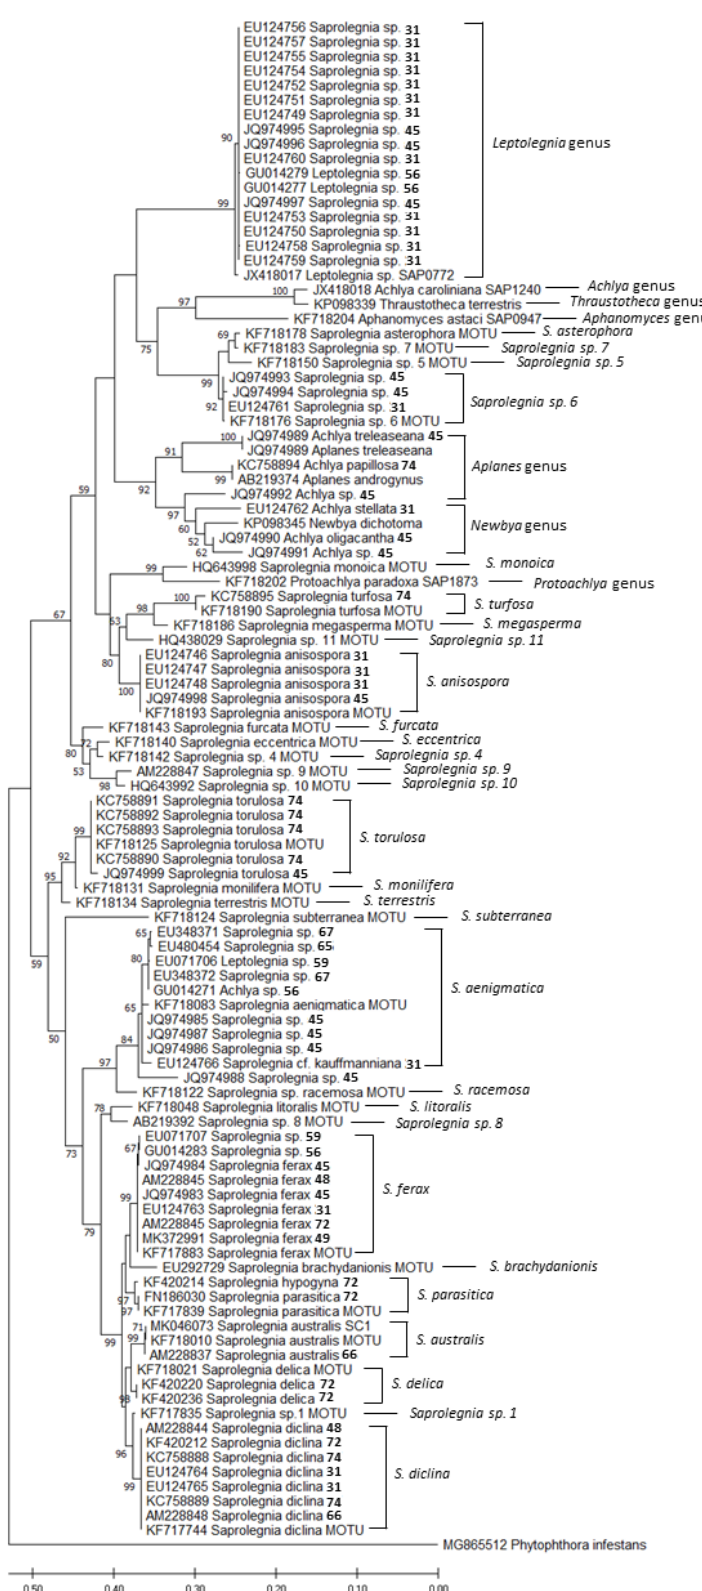
Figure 1. Maximum likelihood phylogram depicting phylogenetic relationships inferred among 105 isolates, based on combined analysis of ITS DNA sequence data. The terminal number corre- sponds to the bibliographic reference whose sequence belongs in Table 1. Bootstrap values (>50%) are presented to the right of each